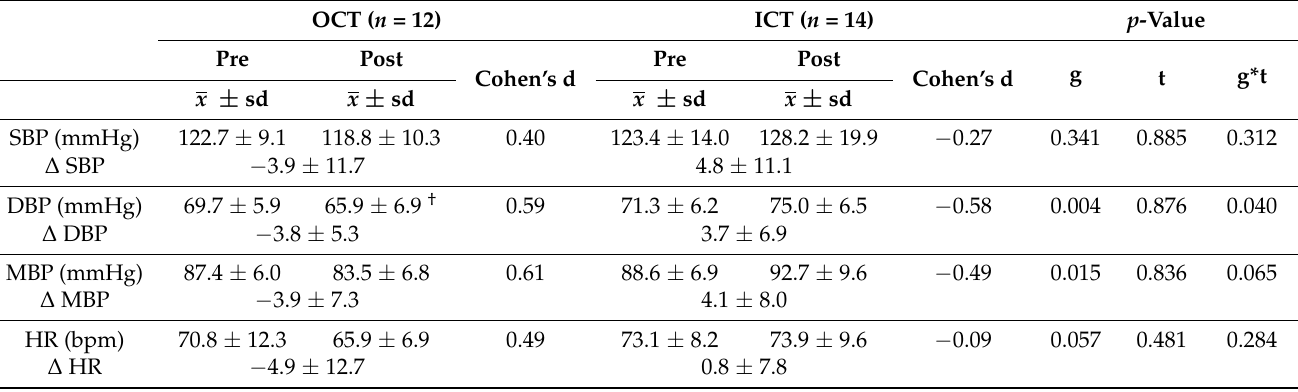
Table 2. Effects of combined Outdoor and Indoor training on BP and HR ( n = 26).